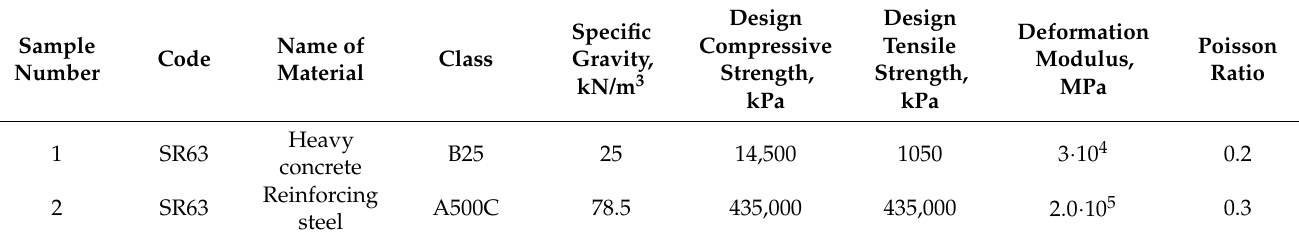
Table 1. Characteristics of the materials used in the